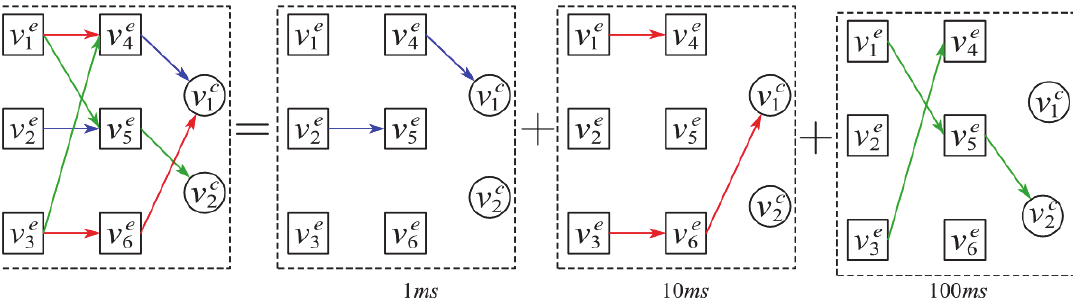
Figure 1. A simple example of TVPHAG.